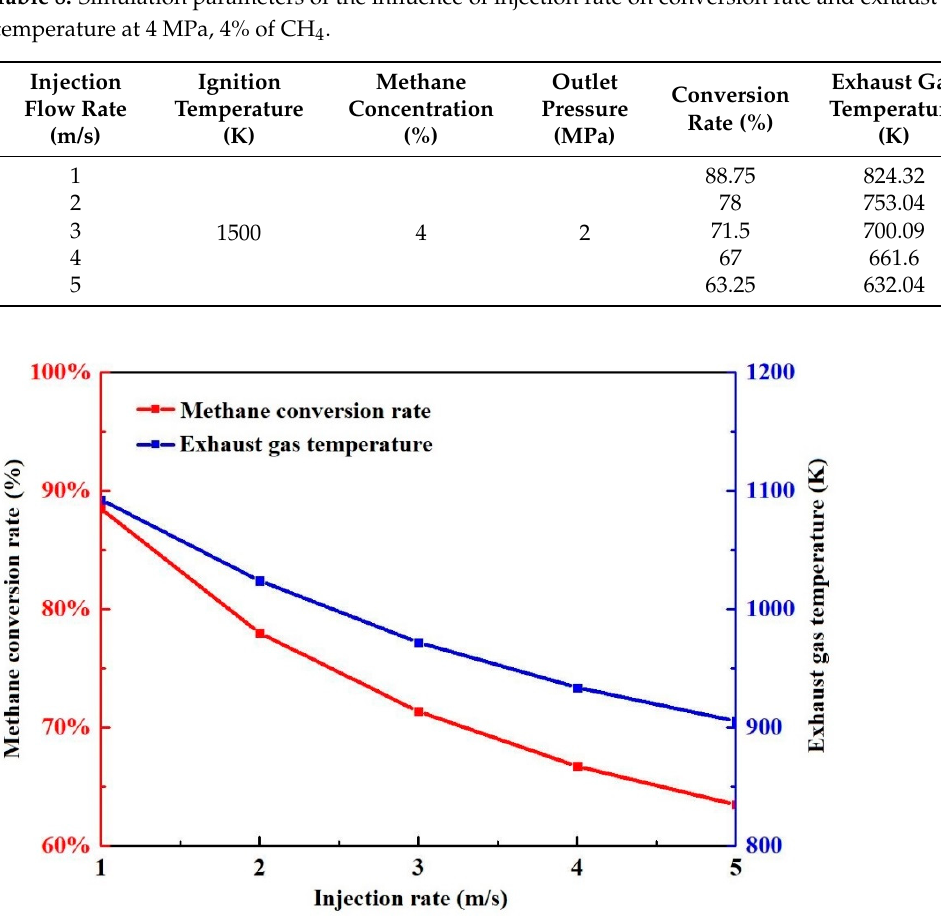
Figure 20. The influence of injection rate on conversion rate and exhaust gas temperature at 4 MPa, 4% of CH 4 .